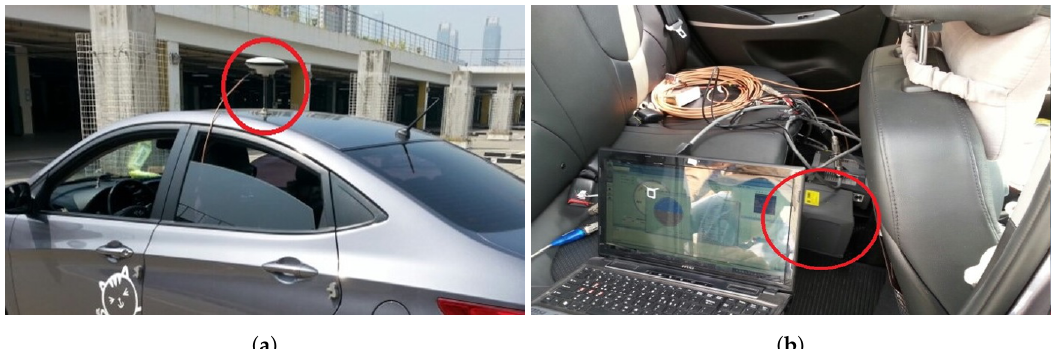
Figure 6. Setting of the experimental devices: ( a ) an antenna on the vehicle and ( b ) IMU in the vehicles.